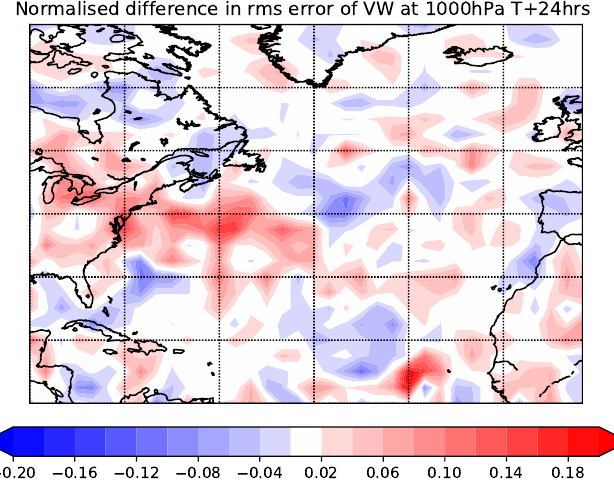
Figure 2. Impact of first implementation of outer loop coupling (quasi strongly coupled data assimilation) on high-resolution global numerical weather prediction (NWP). The presence of model bias in the western boundary currents of the ocean is evident as degradations (red) to the 24 h forecast scores of vector winds (VW) at 1000 hPa. Results were obtained from IFS cycle 45R1 at a resolution of 25 km (TCo399) with a 0.25 ◦ ocean and are based on global outer loop coupling over the period from 1 June 2017 to 2 July 2017. See Section 4 for details of the error